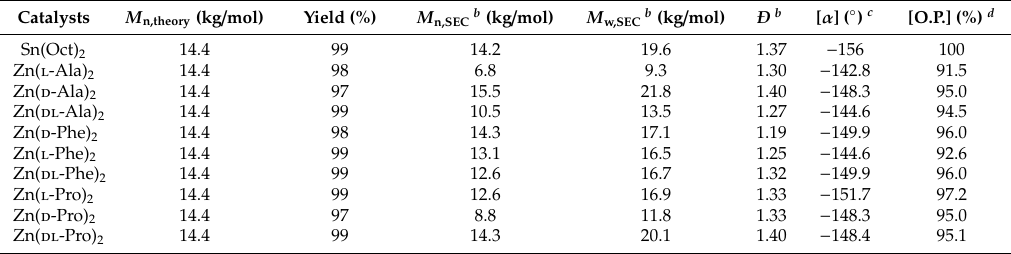
Table 1. Results of PLLA obtained by different zinc salts of amino acids a .